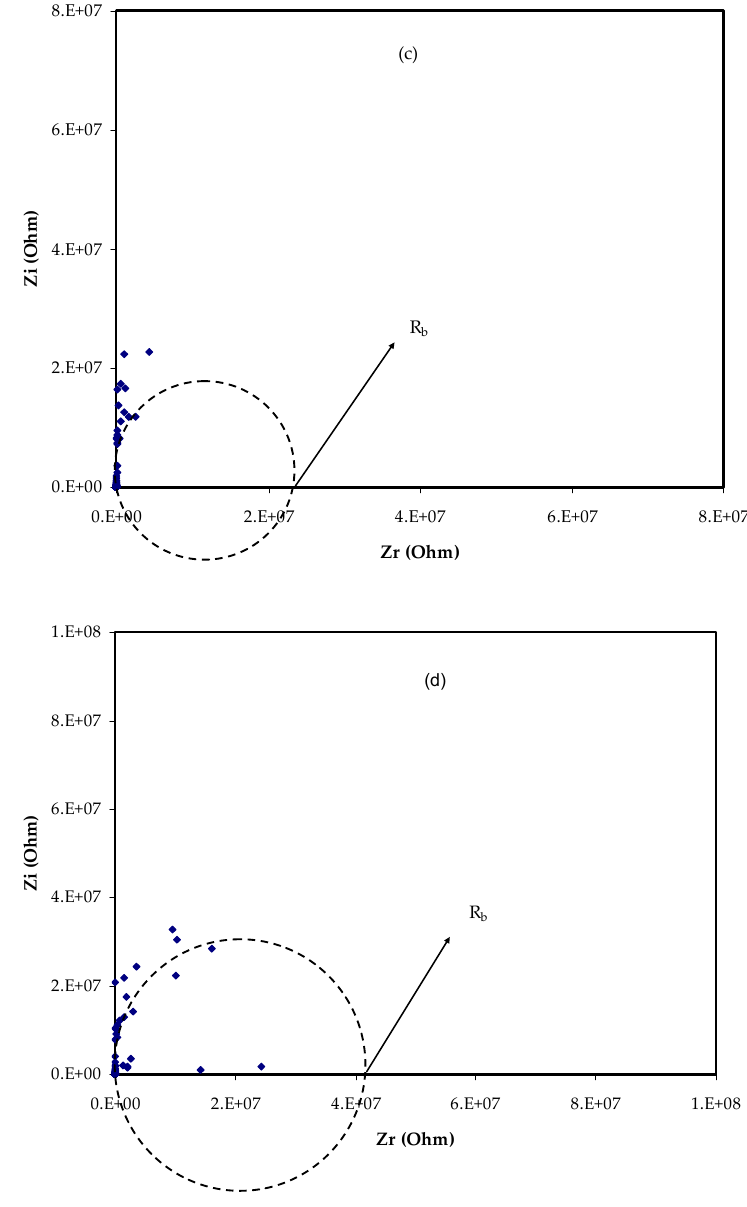
Figure 2. EIS plots for ( a ) PVCNI0, ( b ) PVCNI1, ( c ) PVCNI2, and ( d ) PVCNI3 electrolytes.